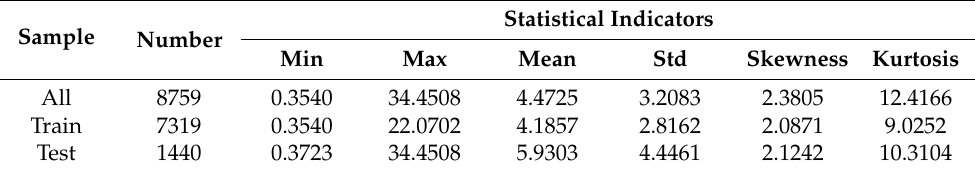
Figure 6. Time series of hourly wind speed data from NREL. Table 1. Statistical results of wind speed used in this study.